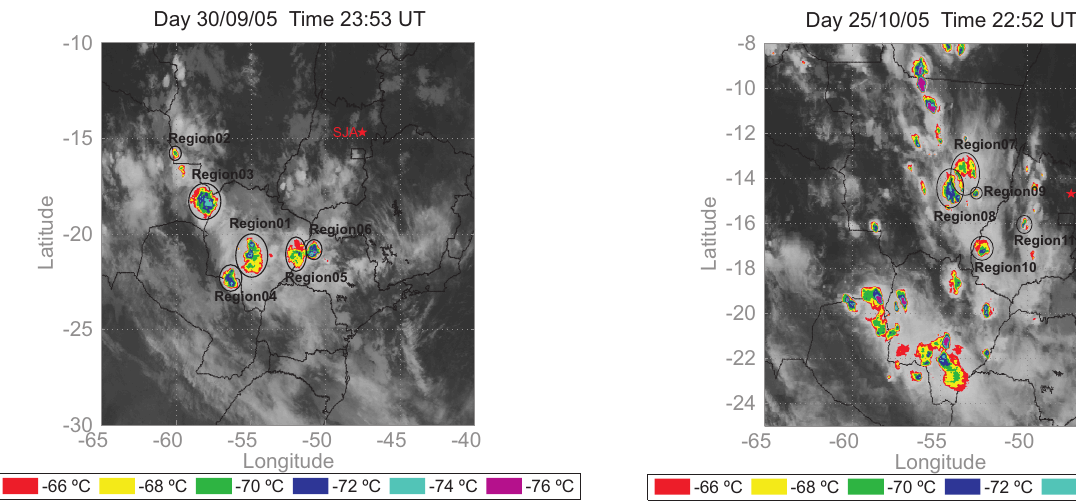
Fig. 3. Grayscale GOES 12 IR image showing the locations of the 5 convective regions of the TLE producing thunderstorms of the night of 25–26 October 2005. The location of the observation site, SJA, is also shown for